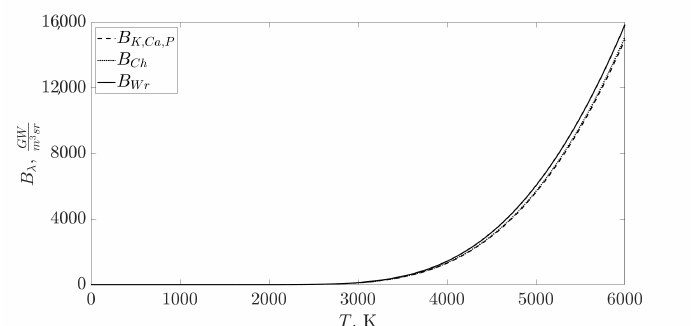
Figure 6. Comparison of the radiation exergy for Karlsson, Candau, Petela, Chen & Mo and Wright et al. considering a constant wavelength of λ = 0.5 µ m and T 0 = 300K.